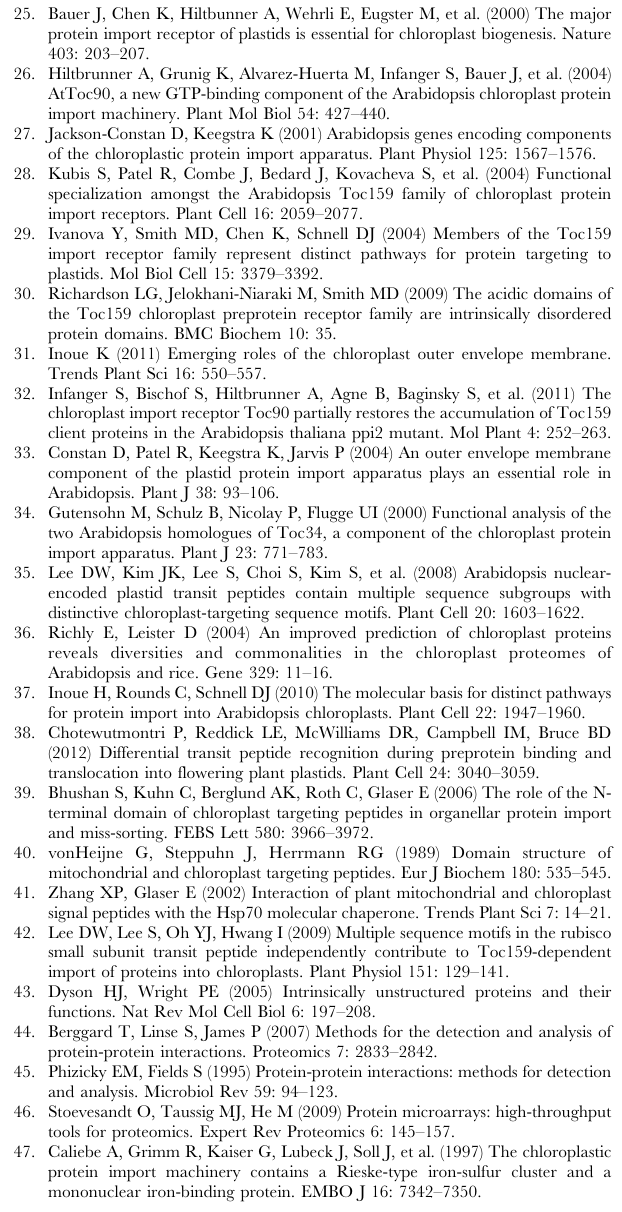
Table S1 Classification of non-photosynthetic (Table 1) and photosynthetic (Table 2) proteins, identified as interactors with atToc159G-, atToc132G- and atTo- c132AG-domain bait proteins according to biological